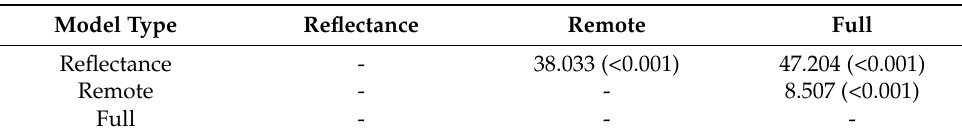
Table 3. Student’s t -tests comparing variation in the mean absolute error of 100 train/test splits for each model type. Numbers represent the t statistic and corresponding p -values in parenthesis from soils ( n = 1738) collected from nineteen participating ranches encompassing approximately 17,347 ha in the Southern Great Plains ecoregion of the United States.